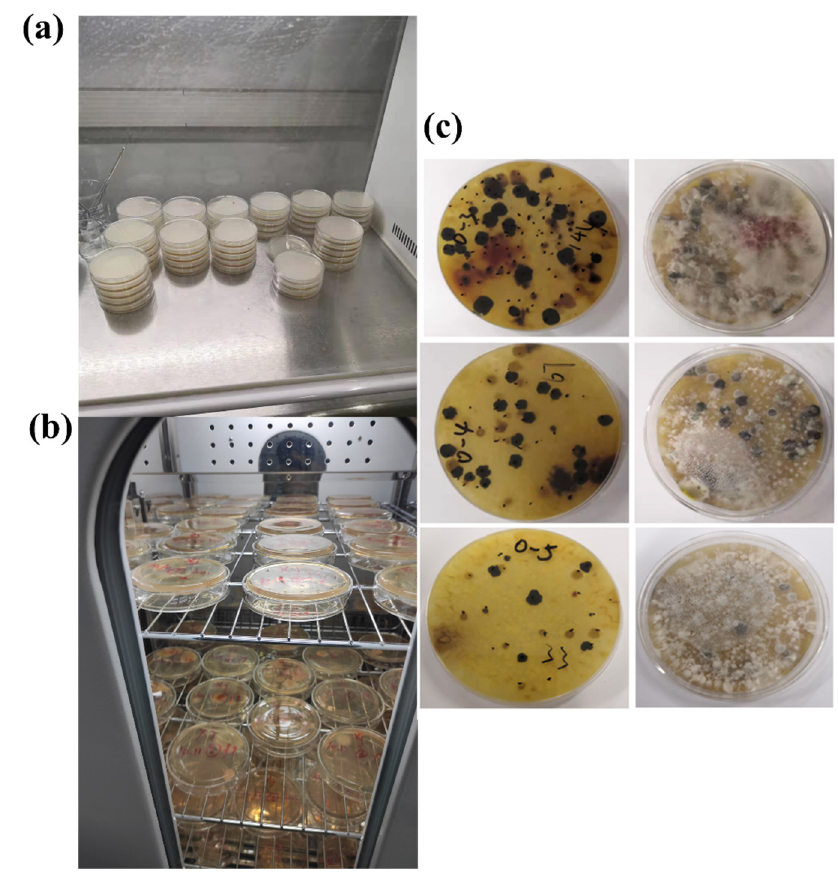
Figure 2. ( a ) Medium preparation process; ( b ) fungal incubation process; ( c ) incubation